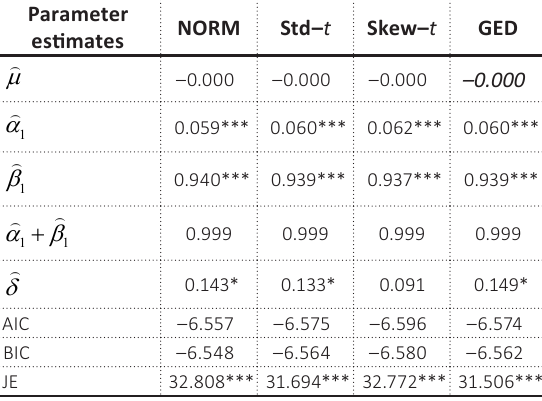
Table 8. ML parameter estimates for GARCH-M with different innovation distributions Parameter estimates